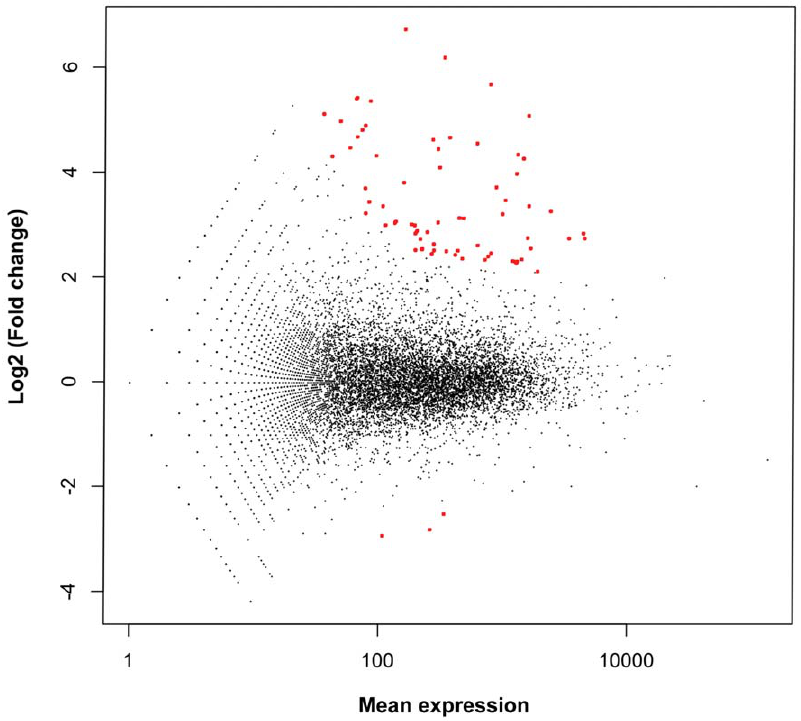
Figure 3. Significance plot. The log2 fold change value of each gene is shown against its base mean value. Differentially expressed genes with statistically significant difference at 5% FDR are indicated by red